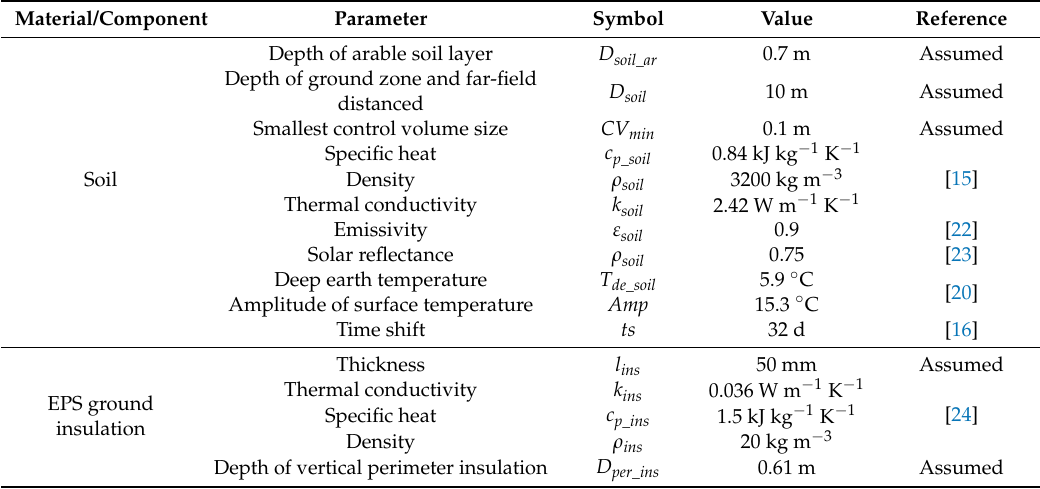
Table 1. Parameter values of different materials/components used in the greenhouse